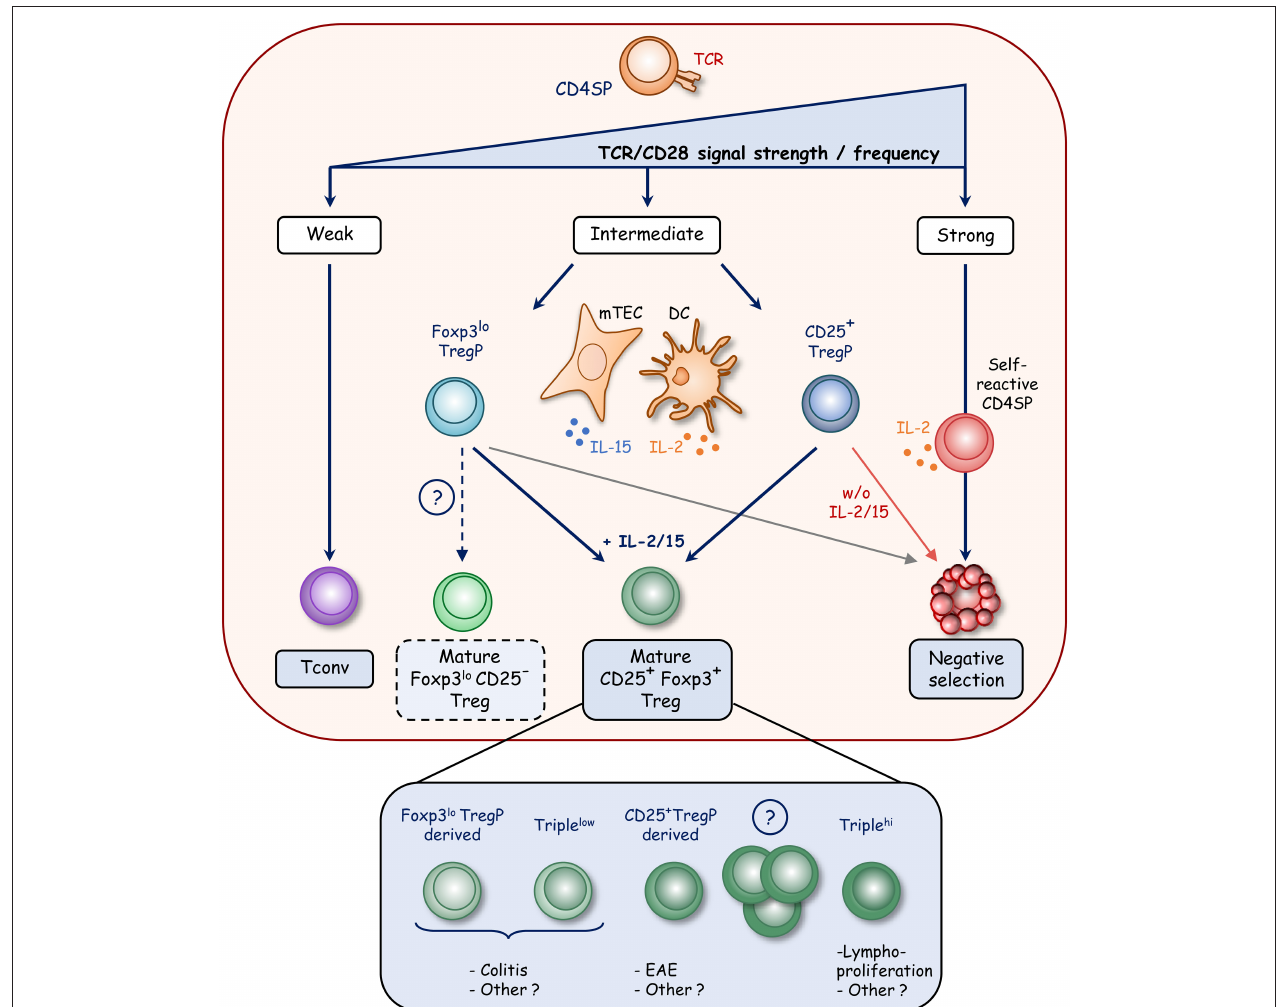
FIGURE 1 | Model of Foxp3 + Treg development in the thymus. During thymic development, strong TCR signals lead to clonal deletion of highly self-reactive CD4 + SP thymocytes whereas weak signals result in the generation of conventional T cells (Tconv). In contrast, intermediate TCR signals result in the diversion of CD4 + SP thymocytes into the Treg cell lineage with the development of two distinct precursors. CD25 + Treg precursors (CD25 + TregP) develop upon strong TCR signals that induce CD25 expression whereas Foxp3 lo Treg precursors (Foxp3 lo TregP) develop upon weaker TCR signals, which drive the upregulation of Foxp3. Further development of these two precursors requires survival signals mediated by γ c cytokine signaling. IL-2 produced by DC and self-reactive CD4 + SP thymocytes and IL-15 produced by mTEC rescue Treg precursors from cell death and lead to mature CD25 + Foxp3 + Treg development. Interestingly, mature CD25 + Foxp3 + Treg appear to have distinct functional properties according to the precursors from which they are derived. CD25 − Foxp3 lo cells also likely contain a subset of mature Treg that egress to the periphery (dotted line). Mature Treg also encompass Triple hi (GITR hi PD1 hi CD25 hi ) and Triple lo (GITR lo PD1 lo CD25 lo ) Treg subsets, which show